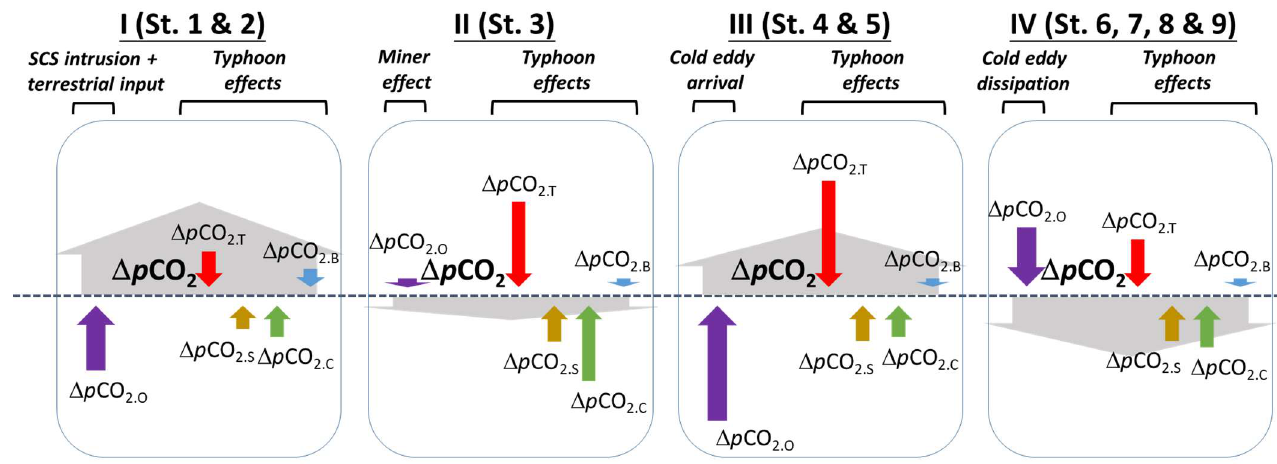
Figure 7. Schematic diagram showing the relative contributions of typhoon-related effects (i.e., temperature (Δ p CO 2.T ; red arrow), salinity (Δ p CO 2.S ; brown arrow), dissolved inorganic carbon/total alkalinity (DIC/TA) (Δ p CO 2.C ; green arrow), and nutrient inputs(Δ p CO 2.B ; blue arrow) and other effects (Δ p CO 2.O ; purple arrow) to the observed p CO 2 variations (grey arrow) after typhoon passage in the four subzones (Zone I, stations 1 and 2; Zone II, station 3; Zone III, stations 4 and 5; and Zone IV, stations 6, 7, 8 and 9; see text for the details).